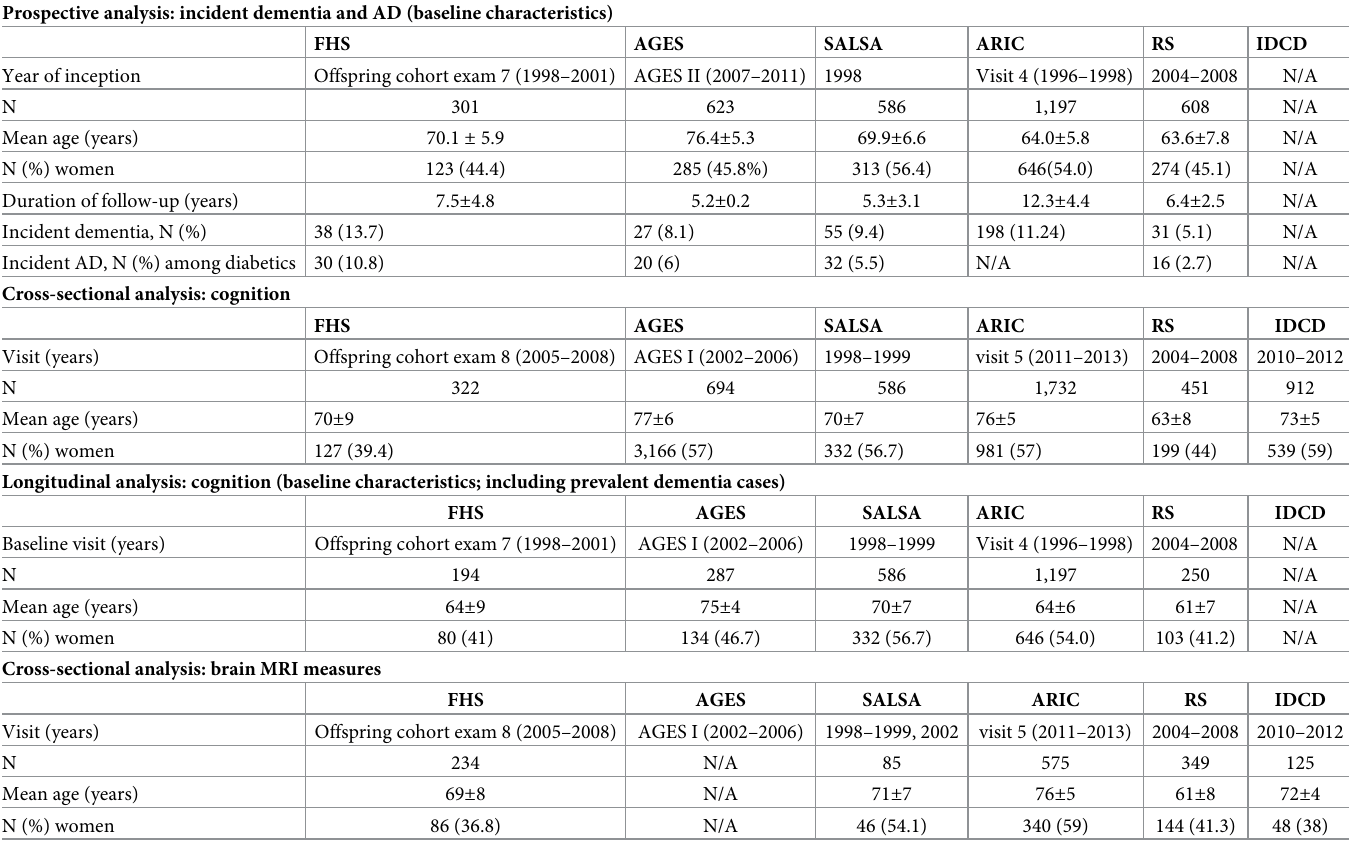
Table 1. Study characteristics of